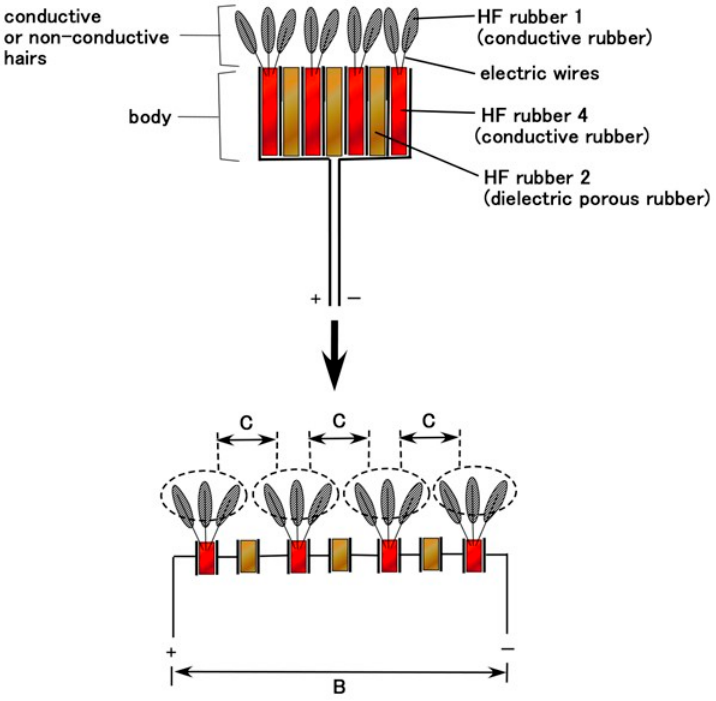
Figure 5. Schematic diagrams of equivalent electric circuit of layered-type Pacinian corpuscles for gustatory receptor.